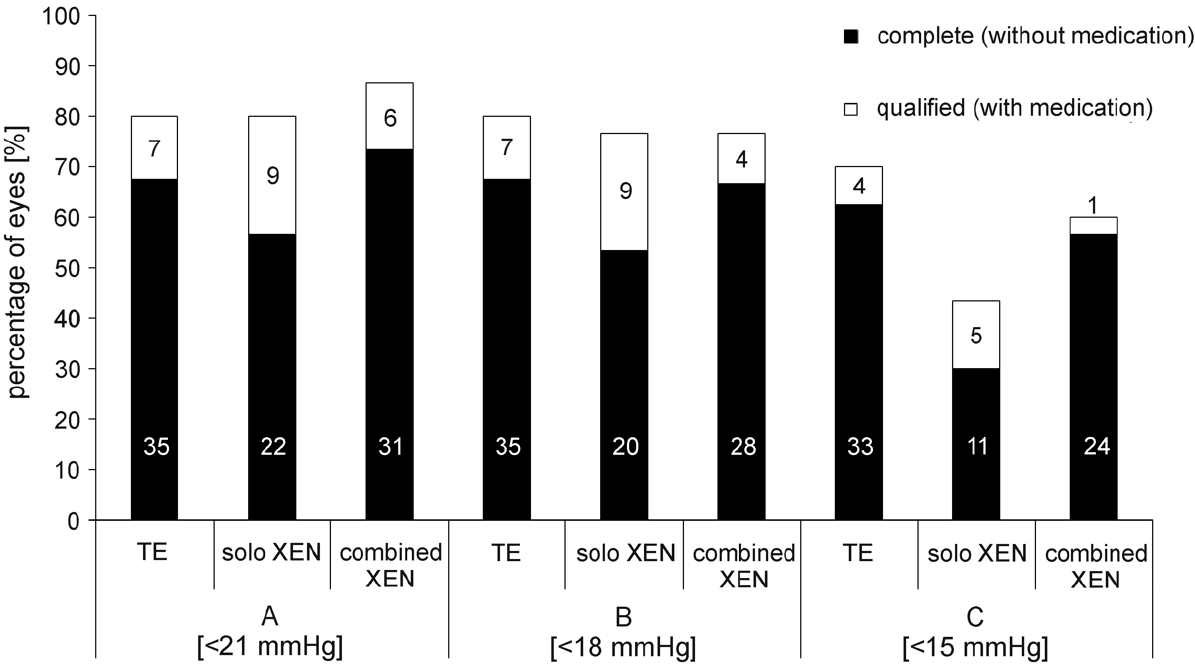
Figure 3. Percentage of eyes achieving complete or qualified success in the three treatment groups 24 months after surgery. A: success level A (IOP < 21 mmHg ± medication); B: success level B (IOP < 18 mmHg ± medication); C: success level C (IOP < 15 mmHg ± medication). In the bars absolute numbers of eyes achieving respective success levels are given.